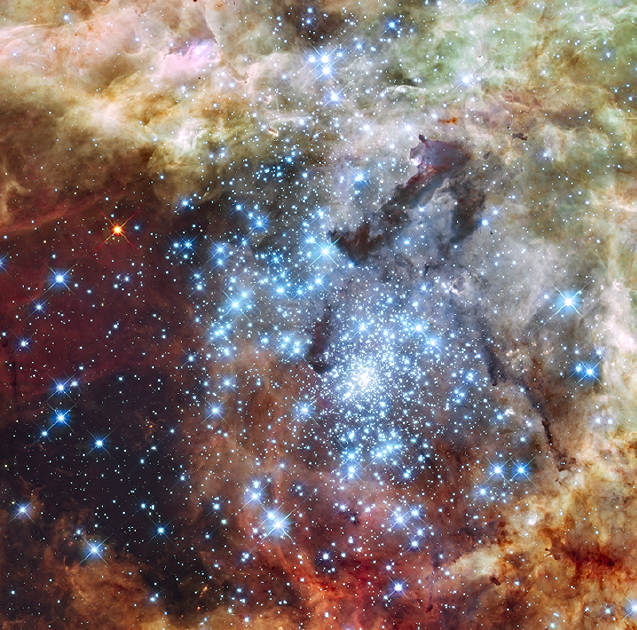
Figure 1. The largest collection of massive stars known in the Local Group of galaxies, the dense cluster at the core of the giant 30 Dor nebula in the Large Magellanic Cloud (LMC). Some of the brightest stars here have masses exceeding 100 Mo. (Image credit: Space Telescope Science Institute; NASA; Hubble Space Telescope.)